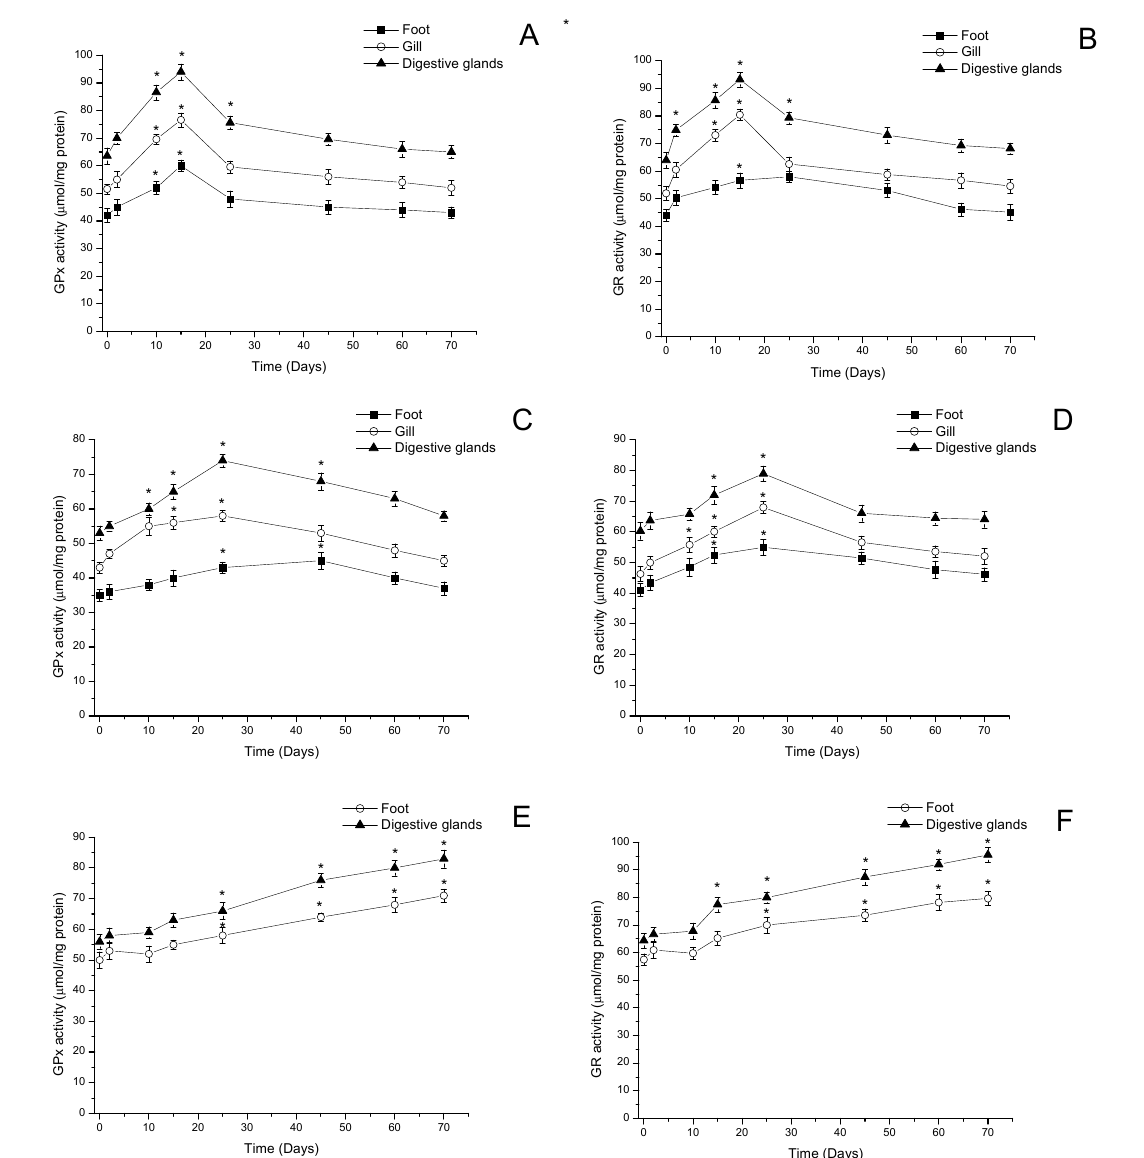
Figure 6. GPx and GR activities in feet, gills, and digestive glands of ( A , B ) mussels ( Mytilus chilen- sis ), ( C , D ) clams ( Ameghinomya antiqua ), and ( E , F ) feet and digestive glands of locos ( Concholepas concholepas ) during a bloom of Alexandrium pacificum . Data are presented as the mean ± SEM. For significant differences compared to control (time point 0), values are indicated by an asterisk (*) in the data ( p < 0.05; Dunnett’s test).